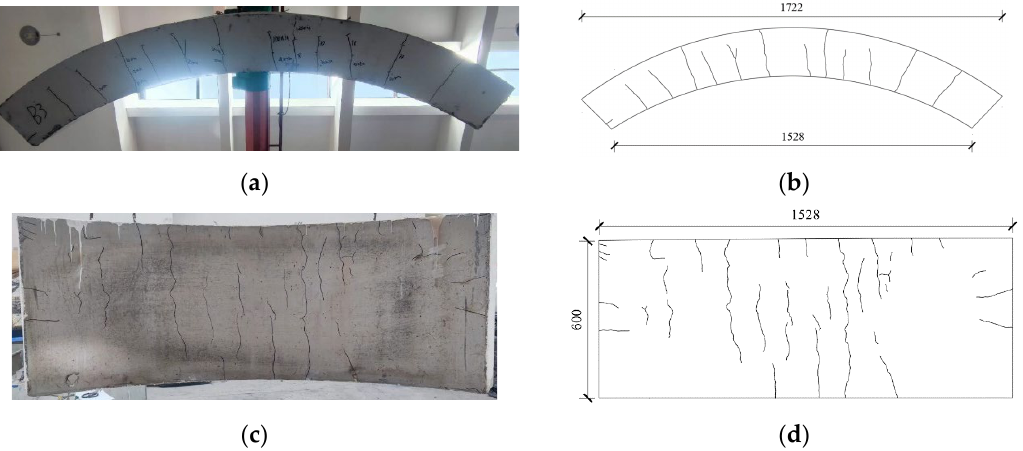
Figure 10. Failure modes of Segment HFRC—4: ( a ) Cracking pattern; ( b ) Crack pattern on the side surface; ( c ) Bottom surface; and ( d ) Cracking pattern on the bottom surface.